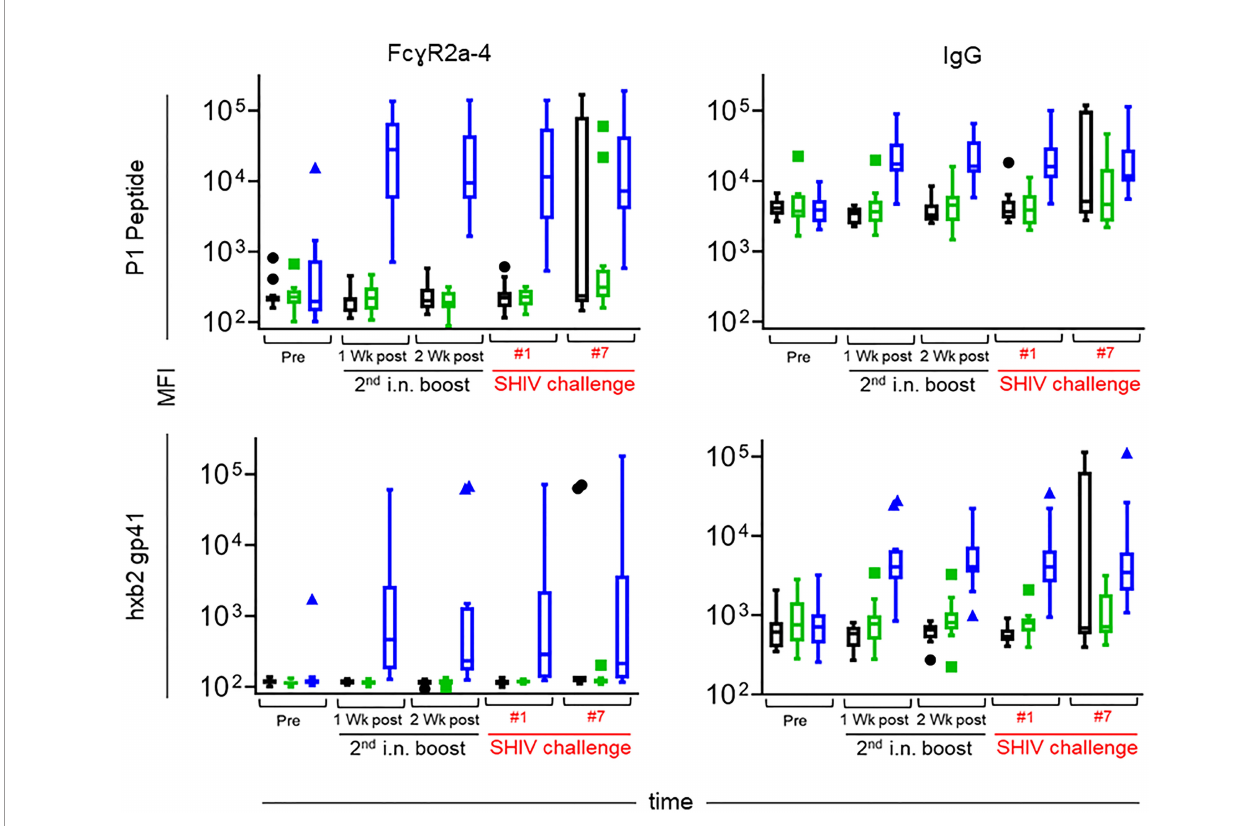
FIGURE 11 | Levels of Fc g R2a-4 binding (left) and total IgG (right) speci fi c for the P1 peptide used as an immunogen (top) and recombinant gp41 from the HxBc2 strain (bottom) over time. Immunization groups are indicated in color; green, Group K; blue, Group L; black, Group M. Time points include pre-immunization (pre), one and two weeks after the 2 nd intranasal boost, the day of the 1 st SHIV challenge, and the day of the 7 th SHIV challenge (please see Figure 3 ). Median fl uorescent intensities (MFI) are reported for each antibody characteristic; group medians are represented by the bar with Tukey ’ s box and